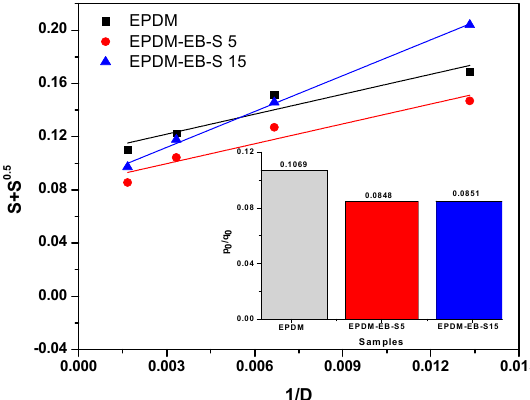
√ S vs. 1 / absorbed dose ( D ) for EPDM-EB-S Figure 12. Plot of S + Figure 12. Plot of S + S vs. 1/absorbed dose ( D ) for EPDM-EB-S composites.